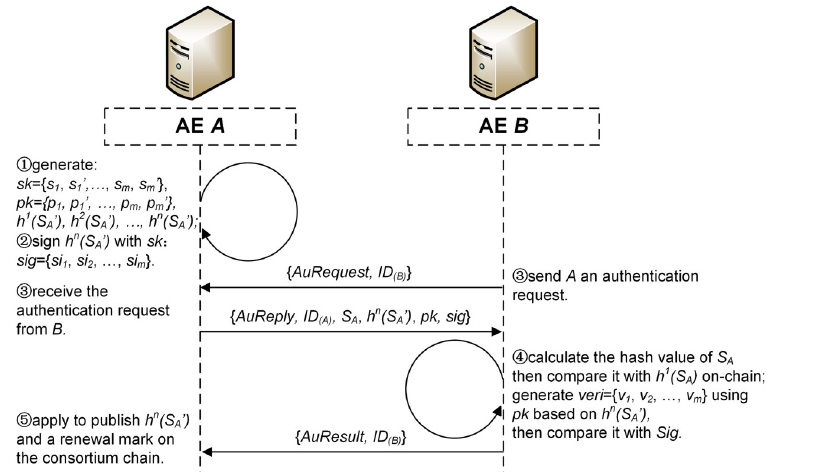
Fig 7. The process of hash chain renewal.